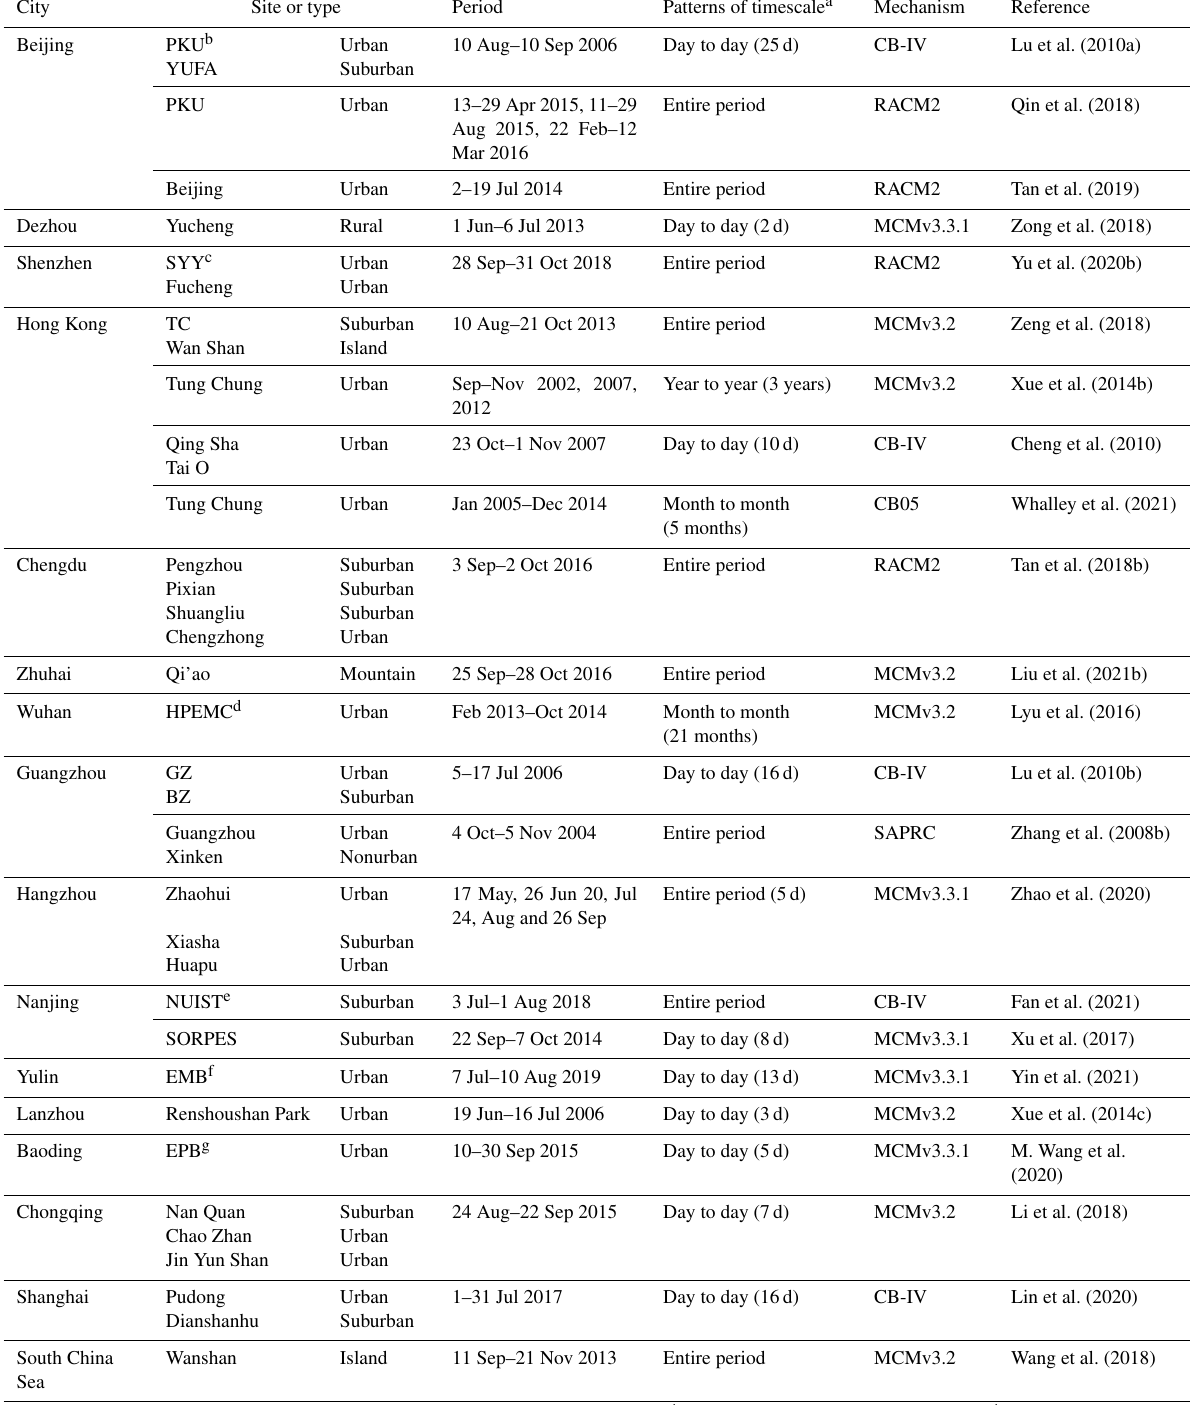
Table 1. Summary of relevant published 0-D box model studies in China.